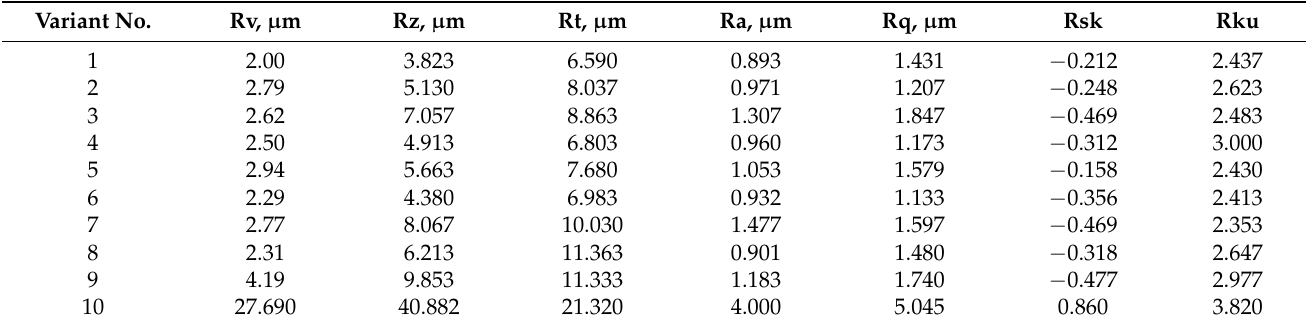
Table 7. Surface roughness parameters in the BM. Variant no.